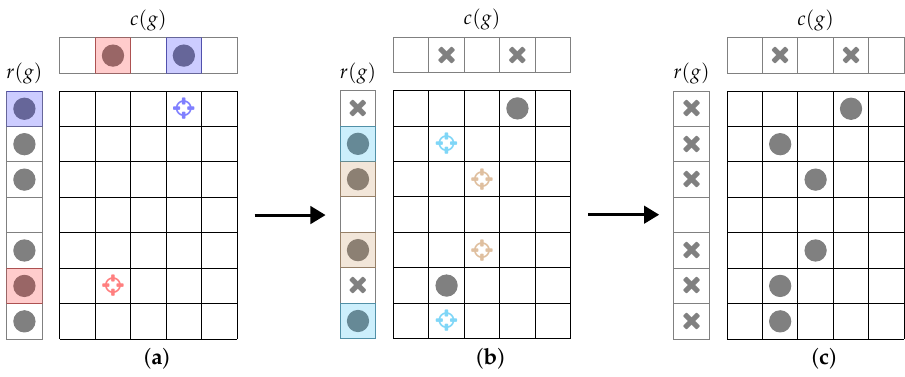
Figure 9. An example of constructing a game from the parity pairs. ( a ) Bit-matching phase. ( b ) Bit- pairing phase. ( c ) Constructed